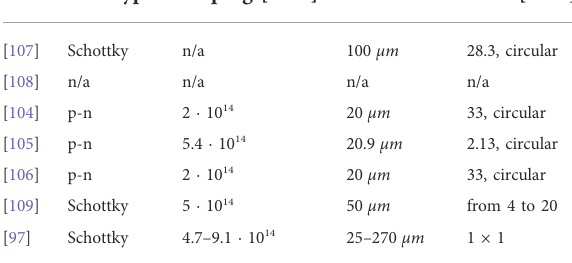
TABLE 4 A list of some works cited in Par. 4.4 with related detector properties. Ref Det.